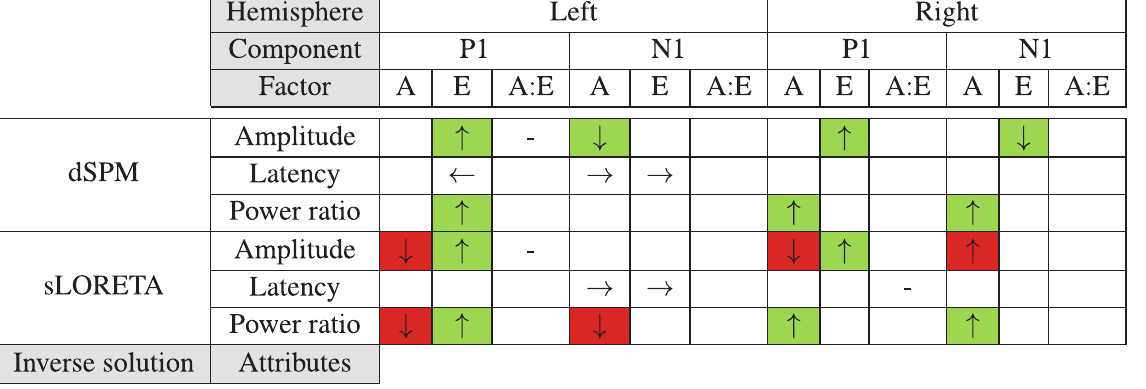
Onlysignificantresultsarereported( p < 0.05).Arrowsindicatethedirectionofchangefromthetemplatefactorleveltotheindividualfactorlevel.Dashesindicateopposinginteractions.